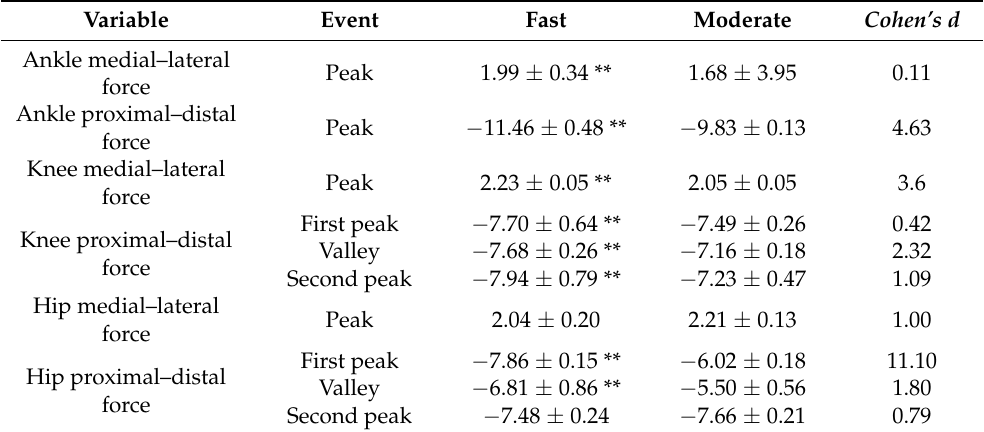
Table 4. The hip, knee and ankle medial–lateral and proximal–distal contact forces (N/BW) in each analyzed